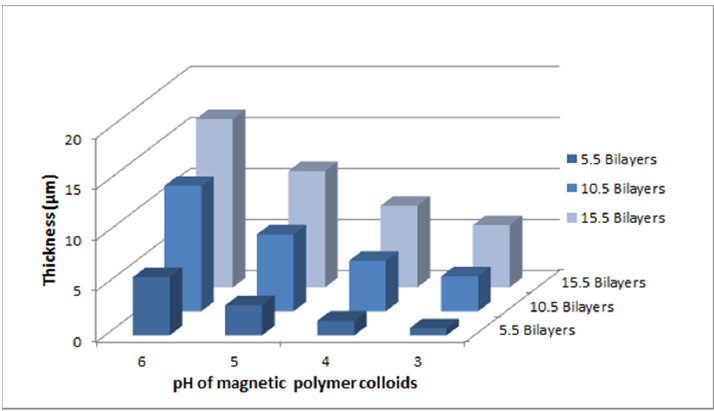
Figure 7. Thickness profile of thin film gradients (A, B, C and D) versus pH of magnetic polymer colloids.